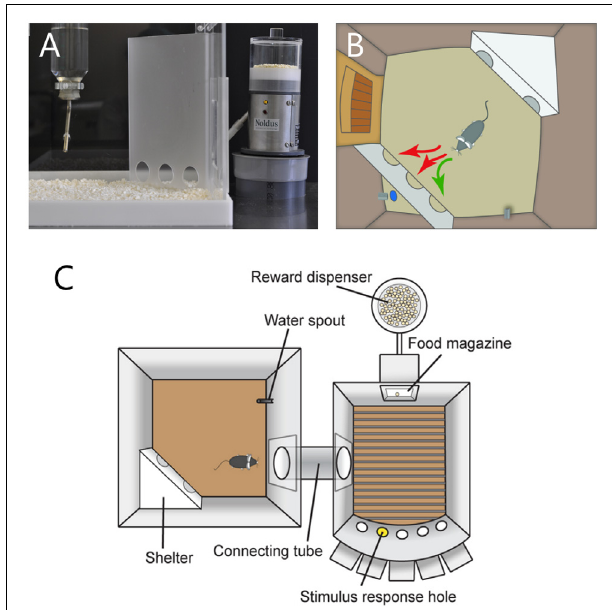
FIGURE 7 | (A) The CognitionWall for identifying discrimination learning impairments. The CognitionWall is an opaque Perspex wall with three entrances that is placed in front of a food dispenser inside PhenoTyper. (B) In the discrimination learning test, mice are rewarded with a food pellet (blue dot) when they choose to pass through one of the three entrances; in this example, the left-most entrance. In the reversal learning test (not shown), the rewarding entrance is switched to another one, for example the right-most entrance. The scheme is adapted from www.sylics.com. (C) Top view of the Combicage. Left, the PhenoTyper home-cage. Right, MedAssociates operant chamber. The test animal can move between the two parts through a custom connection tube. The figure is adapted from Remmelink et al.